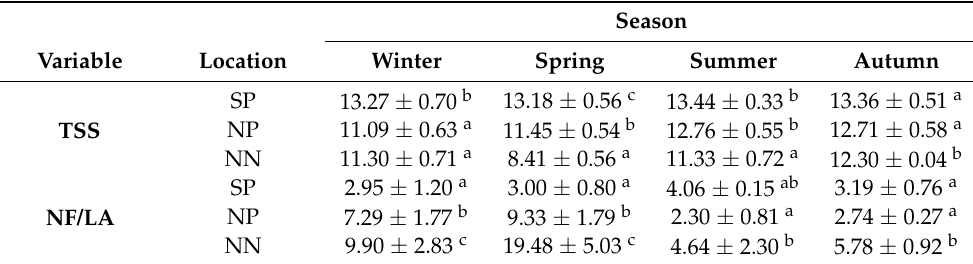
Table 2. Seasonal means for TSS ( ◦ Brix) and NF/LA (number of fruits per leaf area square meter) in the different orchards studied (SP: south and plastic cover, NP: north and plastic cover, and NN: north and net